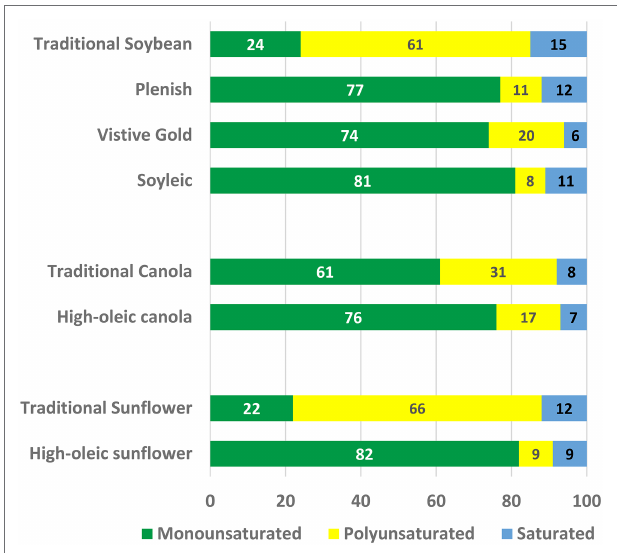
FIGURE 6 | The oil compositions of high-oleic varieties of soybean, canola, and sunflower. The percentages of monounsaturated (mainly 18:1), polyunsaturated (18:2 + 18:3), and saturated (16:0 + 18:0) fatty acids are